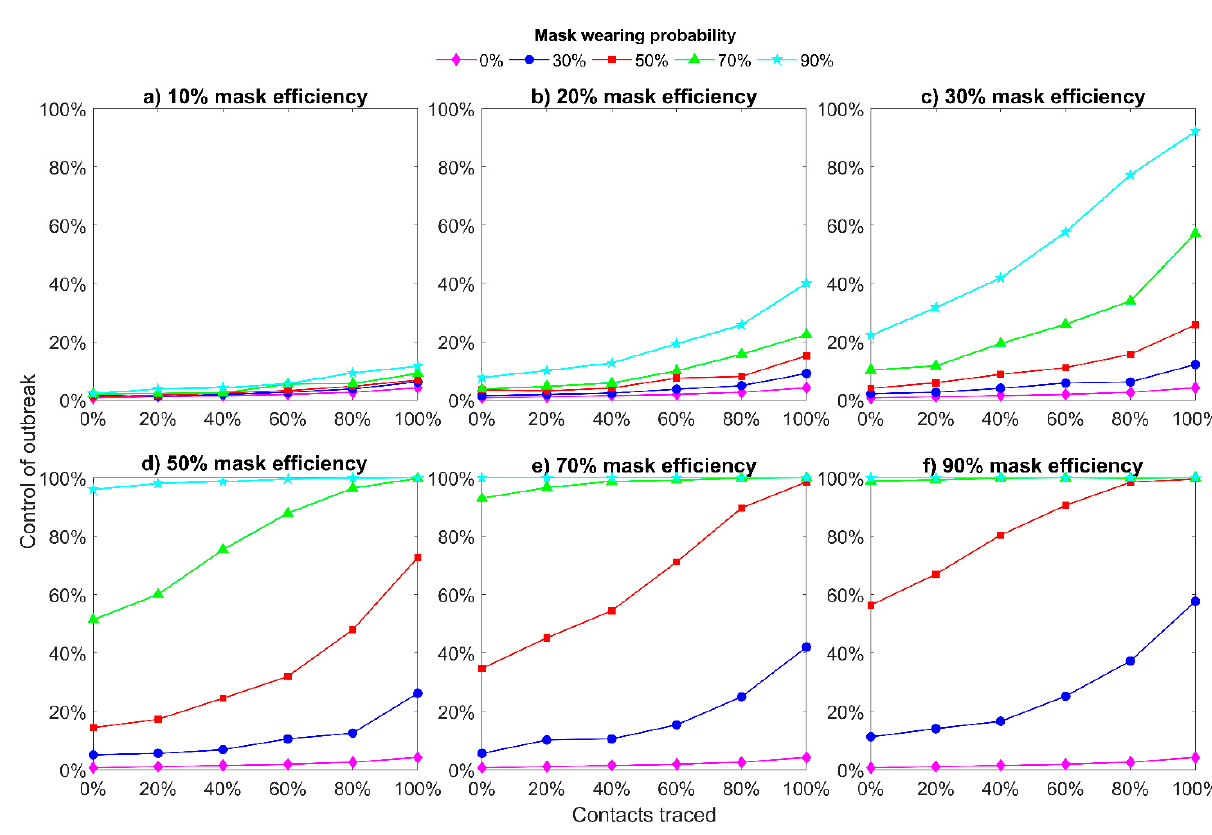
Figure 4. Outbreak control for different mask efficiency. All people wear masks and the mask hinders spreading and protects from getting infection with different efficiency. 20 initial symptomatic cases, 20 initial asymptomatic cases, initial R 0 = 2.5, R a = 1.875, 4 days of mean delay, 40% transmission before symptoms.